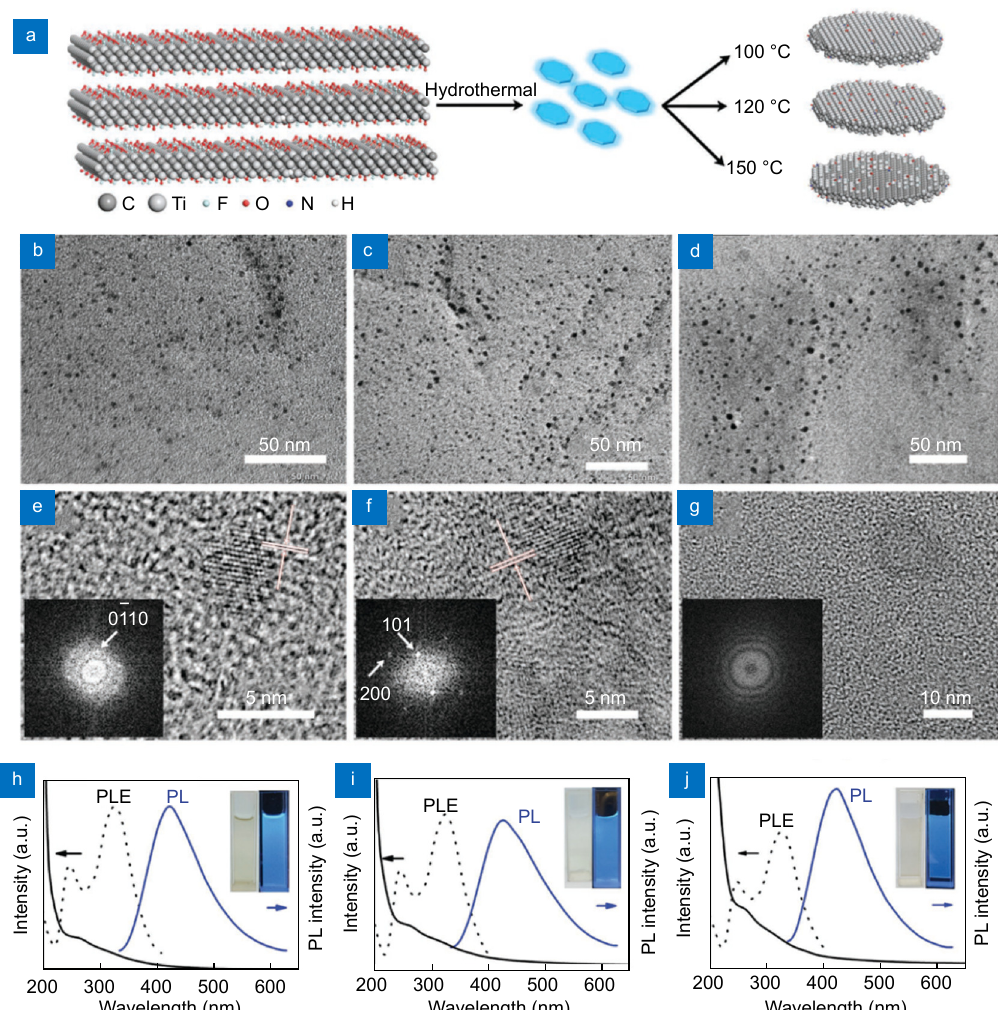
Fig. 6 | ( a ) MQD preparation by the hydrothermal method. TEM and HRTEM images of ( b,e ) MQD-100, ( c,f ) MQD-120, and ( d,g ) MQD-150. UV–vis spectra, PLE, and PL of ( h ) MQD-100, ( i ) MQD-120, and ( j ) MQD-150 in aqueous solutions. The figures were reproduced with